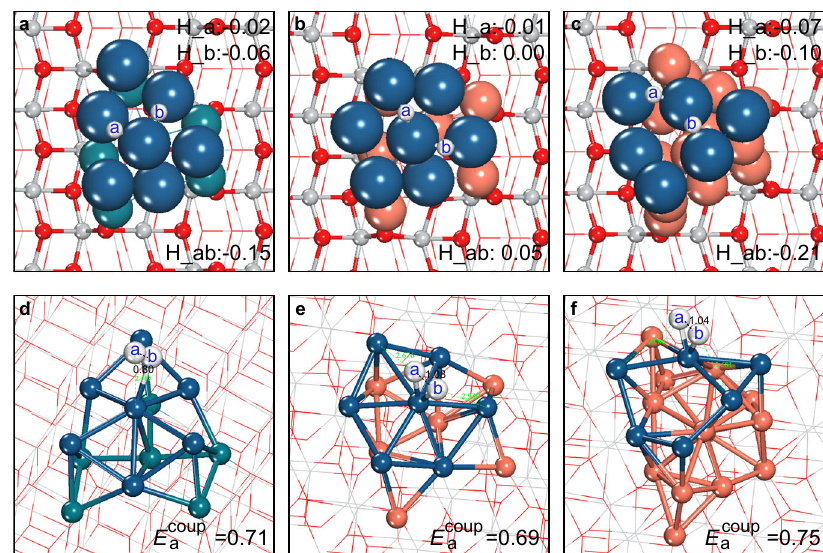
Fig. 3 Calculated structures and energies for H adsorption and H – H coupling on proposed metal/TiO 2 composites. a – c H adsorption at two reactive sites (labeled as a and b) and d – f transition states of H – H coupling on the Pt 7 Rh 6 /TiO 2 , Pt 7 Cu 6 /TiO 2 , and Pt 6 Cu 13 /TiO 2 composites, respectively. Gibbs adsorption energies for the independent adsorption of H atom on each of the two reactive sites (H_a and H_b), the co-adsorption of two H atoms (H_ab), as well as the H – H coupling barrier E a coup , are given in